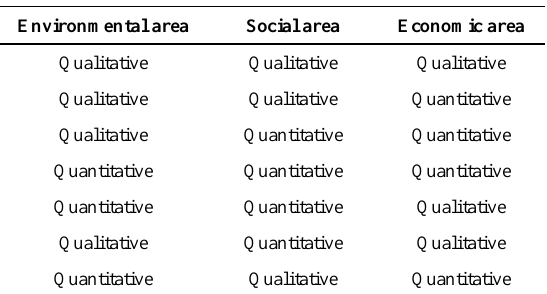
Table 8. Combination